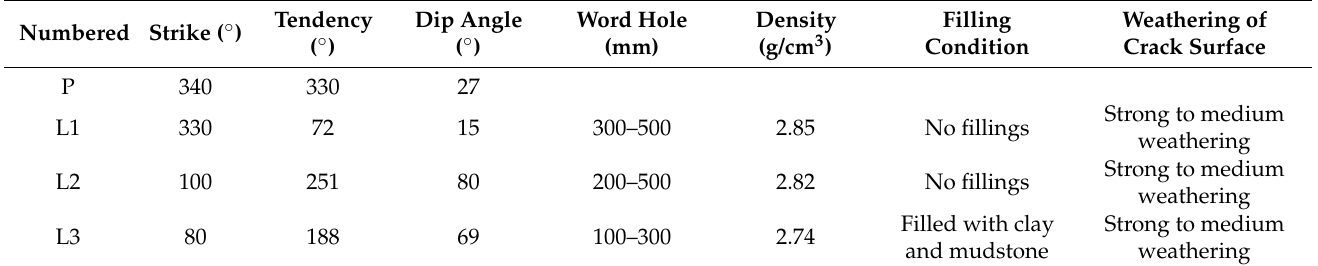
Table 2. Collapsed perilous rock belt of the coal mine industry square.